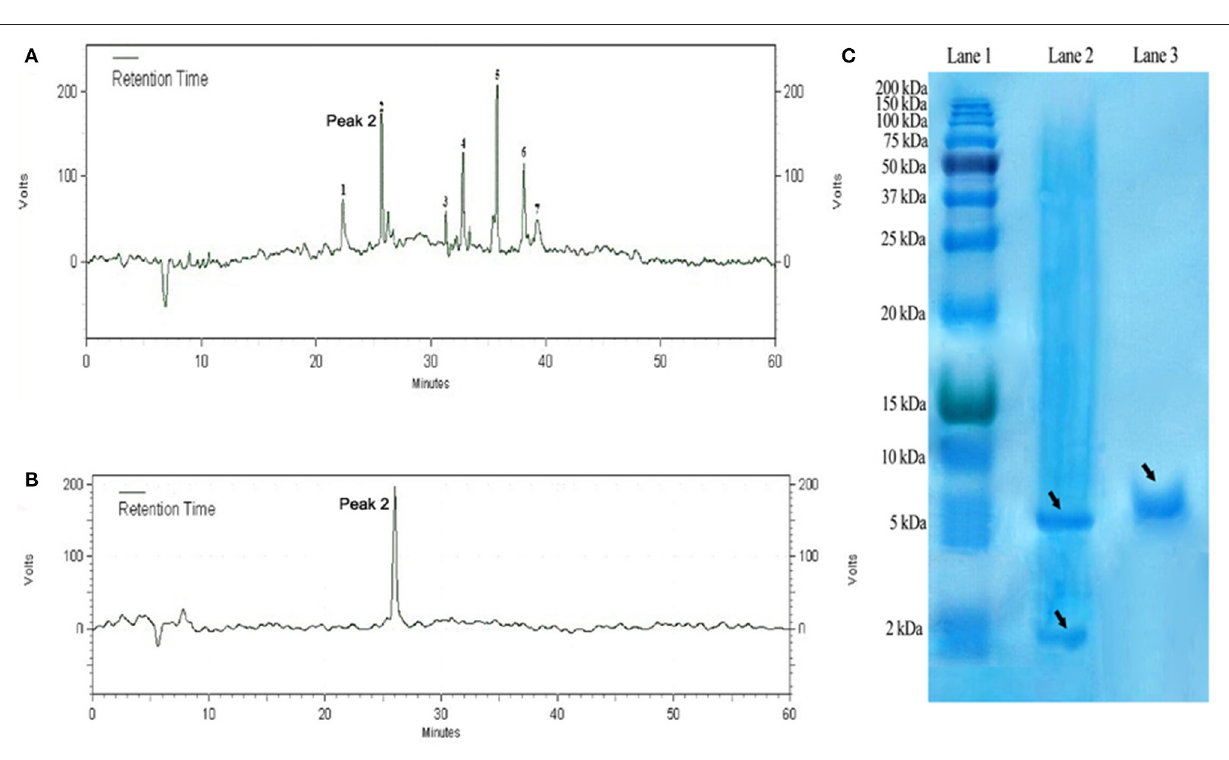
was − 66 kcal/mol. The obtained data demonstrated that